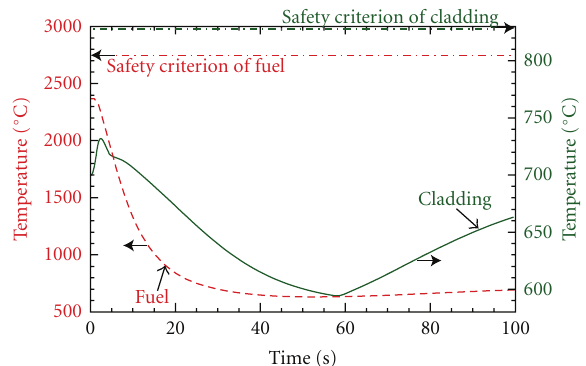
Figure 6: Loss-of-o ff site power event (short term after the event